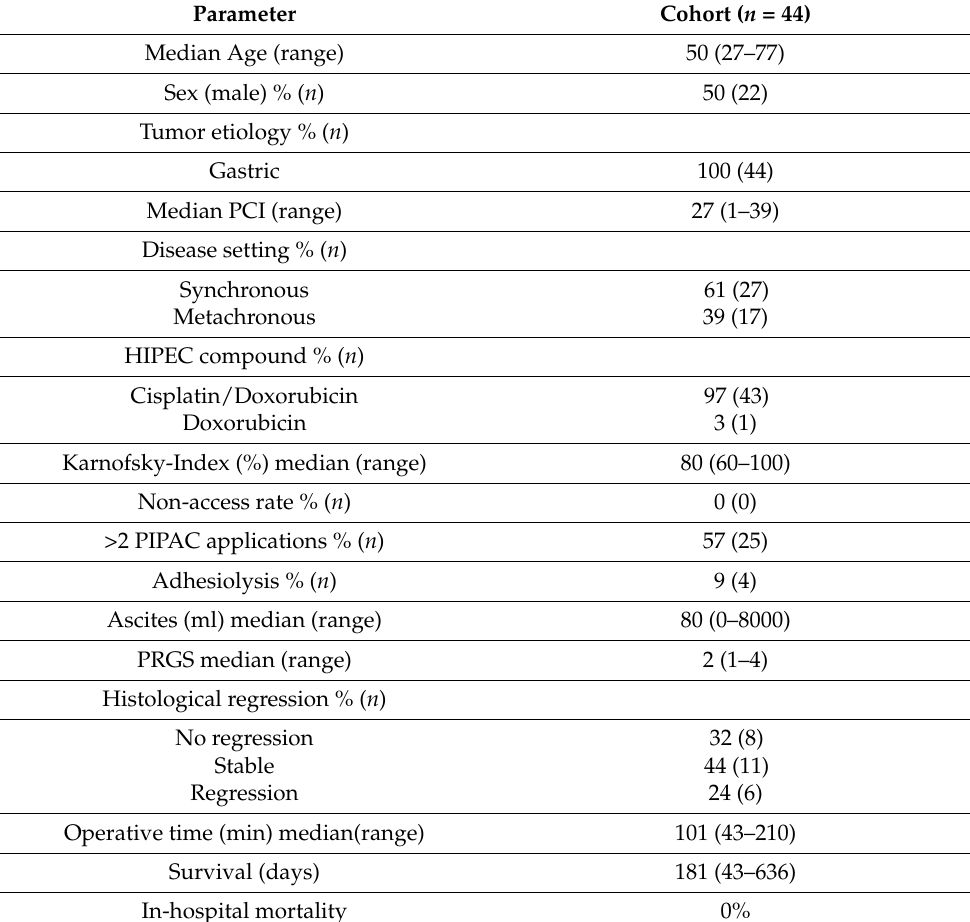
Table 2. Patients- and treatment-related parameters of the single center data (PCI = peritoneal